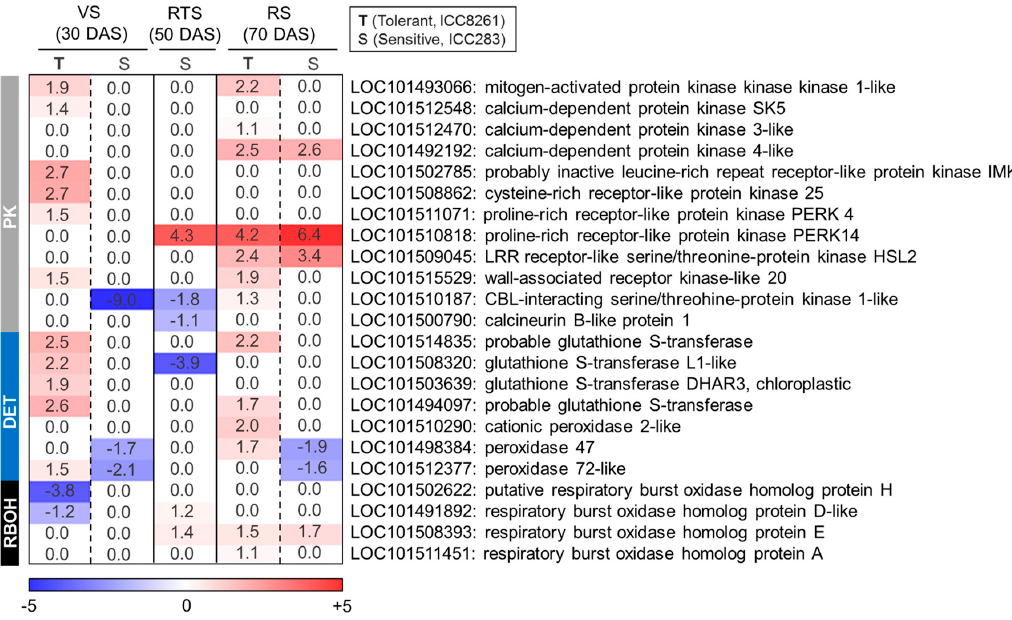
Figure 5. Heat map illustrating differential expression of various protein kinases (PK), detoxification enzymes (DET) and respiratory burst oxidases (RBOH) in the tolerant (T, ICC8261) and sensitive genotype (S, ICC283) at vegetative (VS), reproductive transition (RTS) and reproductive (RS) stages. The scale color represents log2 fold change.